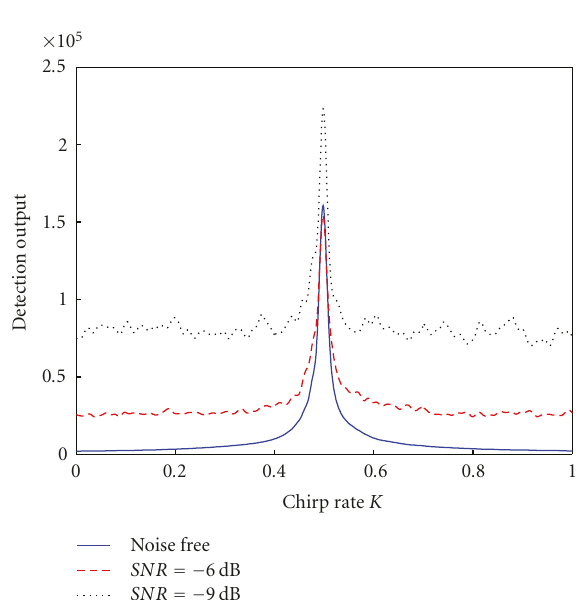
Figure 2: The detection output of single-component LFM-signal using 4th-power modulus form. Solid line: SNR = ∞ . Dashed line: SNR = − 6dB. Dotted line: SNR = − 9 dB.